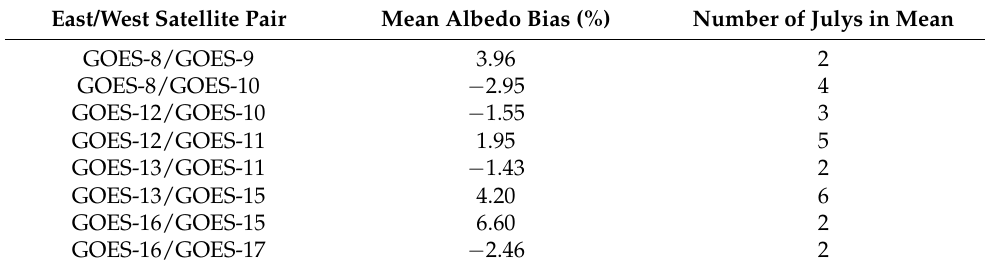
Figure 12. Cloud-albedo time series from GOES-East and GOES-West from GOES-IP and GOES-R. Region analyzed is 18–24N, 118–124W, and it is shown from the east and west view in the images in the upper left and right corners. Table 6. Mean cloud albedo bias for the Baja stratus region shown in Figure 12 for the month of